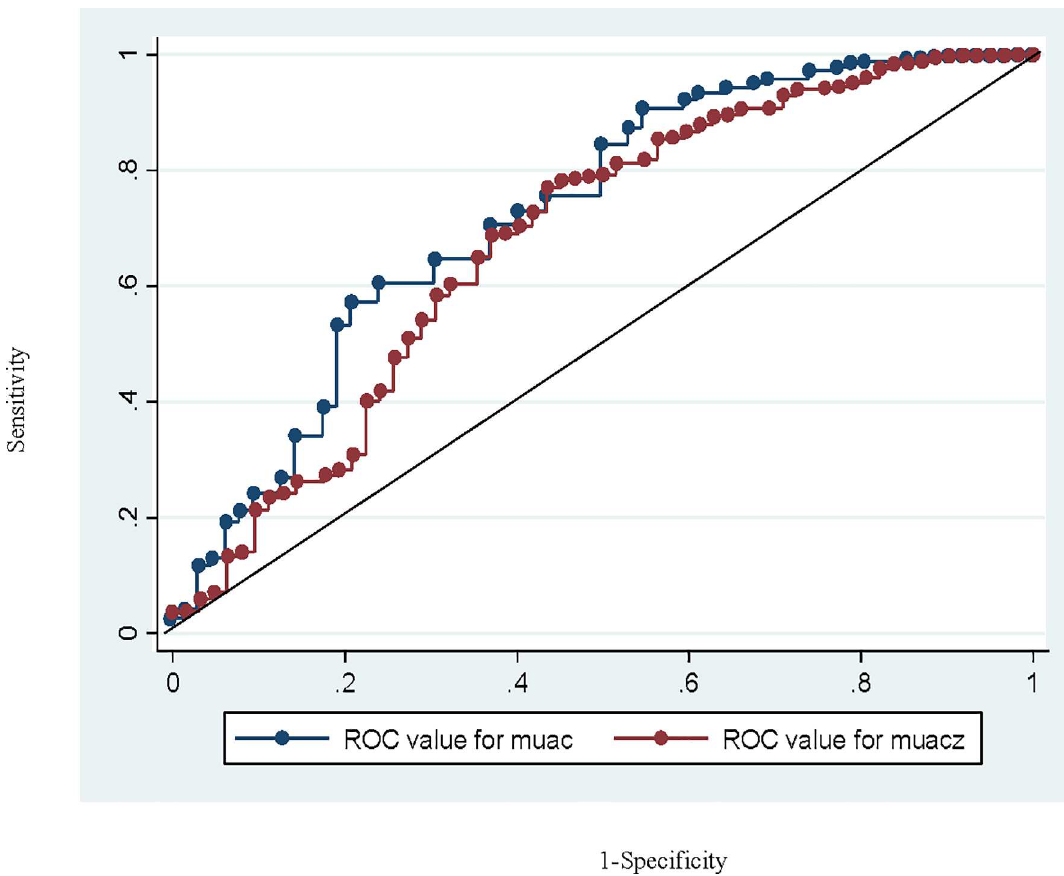
Fig 2. ROC curve of MUAC and MUAC